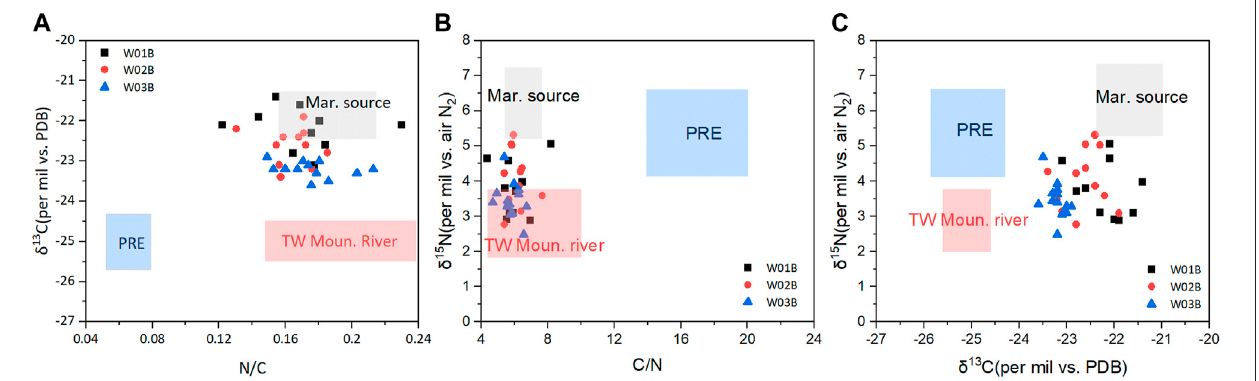
FIGURE 5 | Cross-plots of (A) N/C ratio versus δ 13 C, (B) δ 15 N versus C/N ratio, and (C) δ 15 N versus δ 13 C, modi fi ed from Yang J.-Y. T. et al. (2017). The gray shaded areas indicate marine source (Mar. source) organic matter (Liu K.-K. et al., 2007; Kao et al., 2012). The blue shaded areas represent the organic matter from the PearlRiverestuary(PRE)(Huetal.,2006;LiuK.-K.etal.,2007;Gayeetal.,2009;Zhangetal.,2014b).ThepinkshadedareassymbolizeorganicmatterfromtheTaiwan mountainous river (TW Moun. river) (Kao et al., 2006; Gaye et al., 2009; Yang J.-Y. T. et al.,